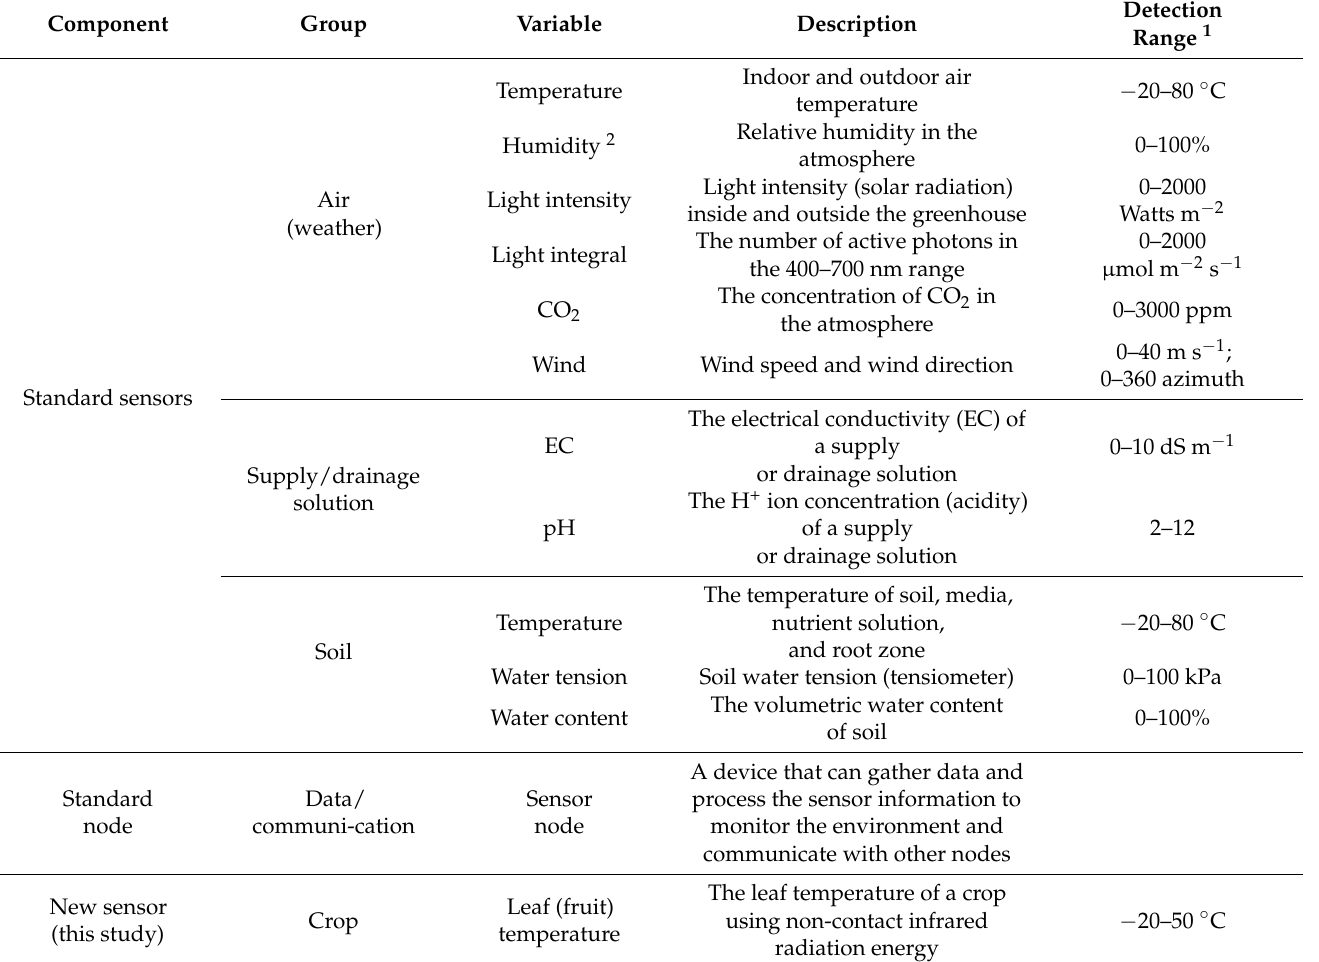
Table 1. A “KS X 3266” smart greenhouse, equipped with standard sensors for monitoring in- door/outdoor environments (references) and a leaf temperature sensor (this study). The terms listed here are referenced to the Foundation of Agricultural Technology Commercialization & Transfer, Korea. Group